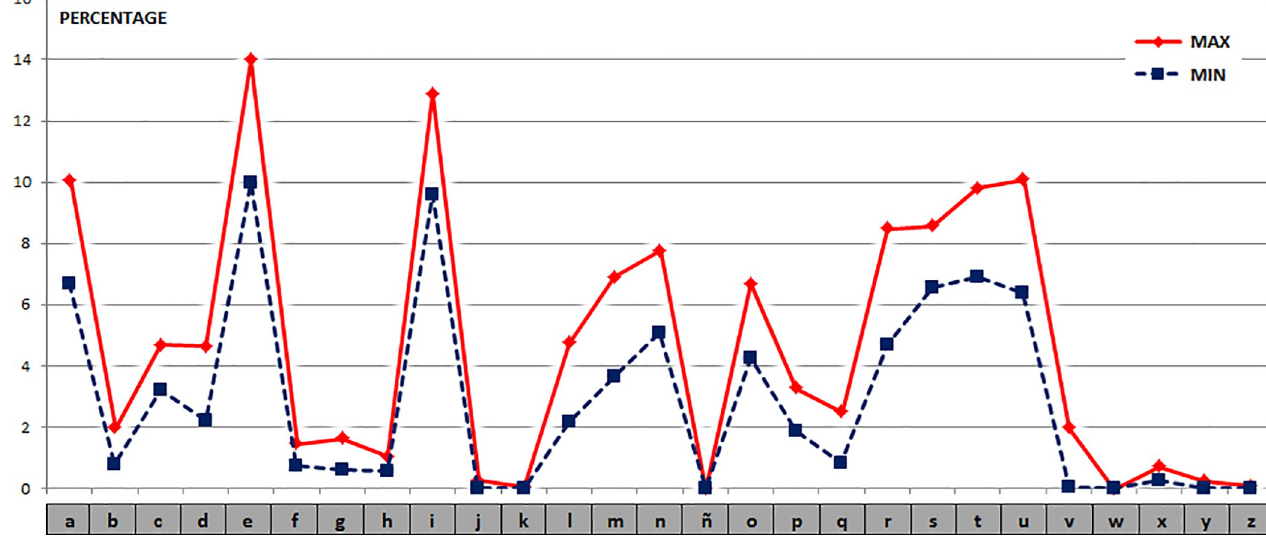
Fig 2. Frequency values of the graphemic units of the 10 Latin